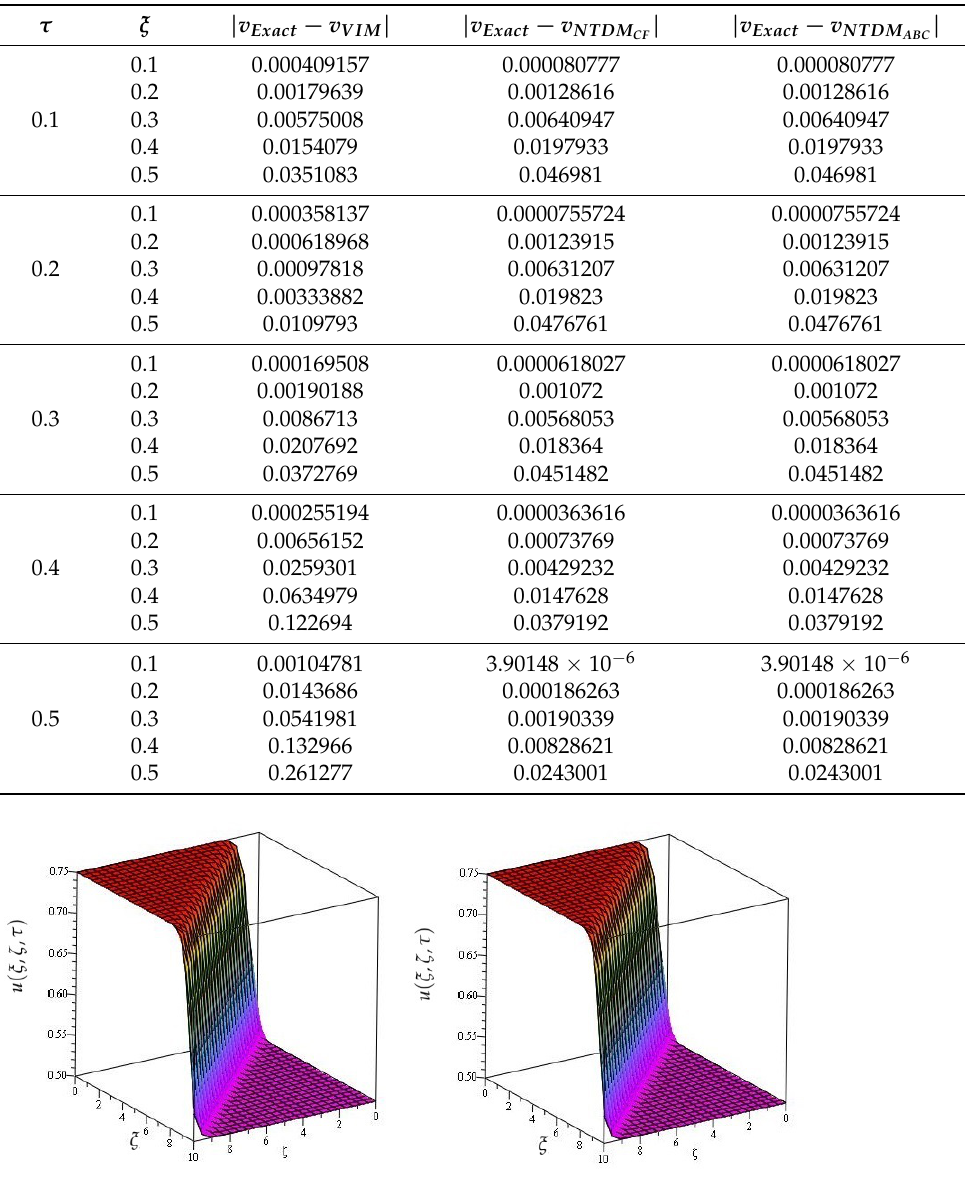
Figure 1. The exact and numerical solutions of u ( ξ , ζ , τ ) of Example 1 at α = 1.